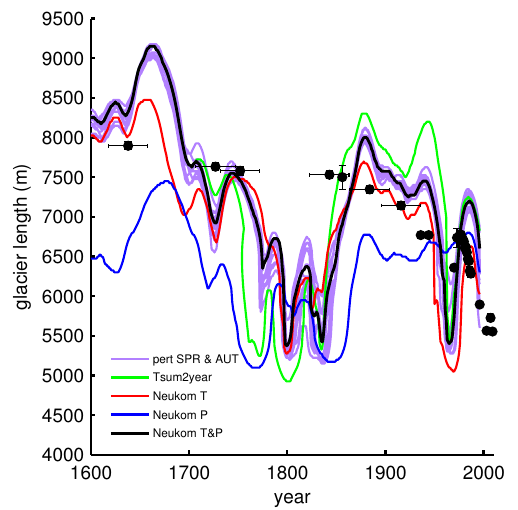
Fig. 12. Sensitivity of the modelled glacier length forced with Neukom et al. (2010, 2011) (black, cf. Fig. 11) to random pertur- bations added to spring and autumn temperature and precipitation (15 purple lines); using summer temperature anomaly as a proxy for annual temperature anomaly (green); only temperature anoma- lies, keeping the precipitation constant at the 1980–2009 level (red); forced with only precipitation anomalies, keeping temperature con- stant (blue). Observed glacier lengths are shown as black